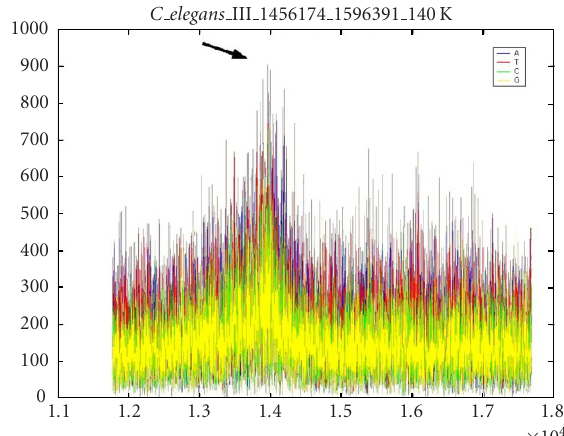
Figure 5: DFT magnitude plot of 140Kbp section of C. elegans chromosome III showing higher values at period 10+ in all bases, but particularly A and T . An arrow marks the peak in the periodic- ity range of